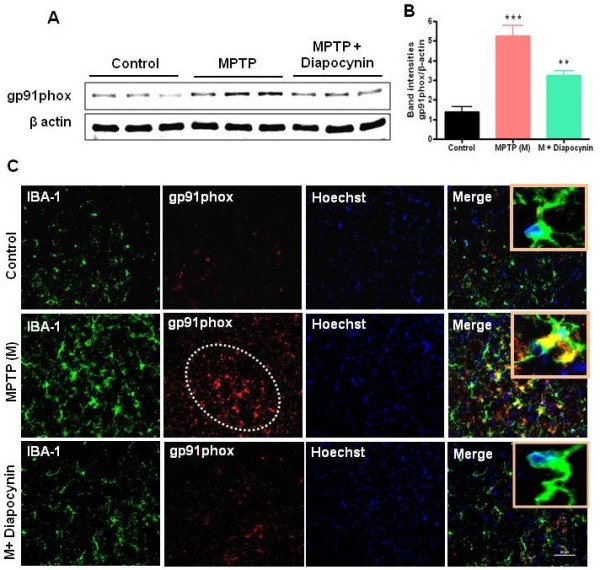
Diapocynin attenuates NADPH oxidase mediated inflammatory responses in the substantia nigra (SN) of MPTP-treated mice. (A) Representative Western blots illustrating the expression of gp91phox (membrane-bound subunit of NADPH oxidase) in SN. (B) Bar graph showing mean Western blot gp91phox/β-actin ratios ± SEM in SN of 6 mice per group. (C) SN tissue sections were double labeled for gp91phox and Iba-1. Images were captured at 20× and 60× (insets) magnification. The SN zone is outlined in white dots. Inset pictures demonstrated colocalization of Iba-1 and gp91phox. ***P <0.001 vs the control group; *P <0.05 vs the MPTP group.